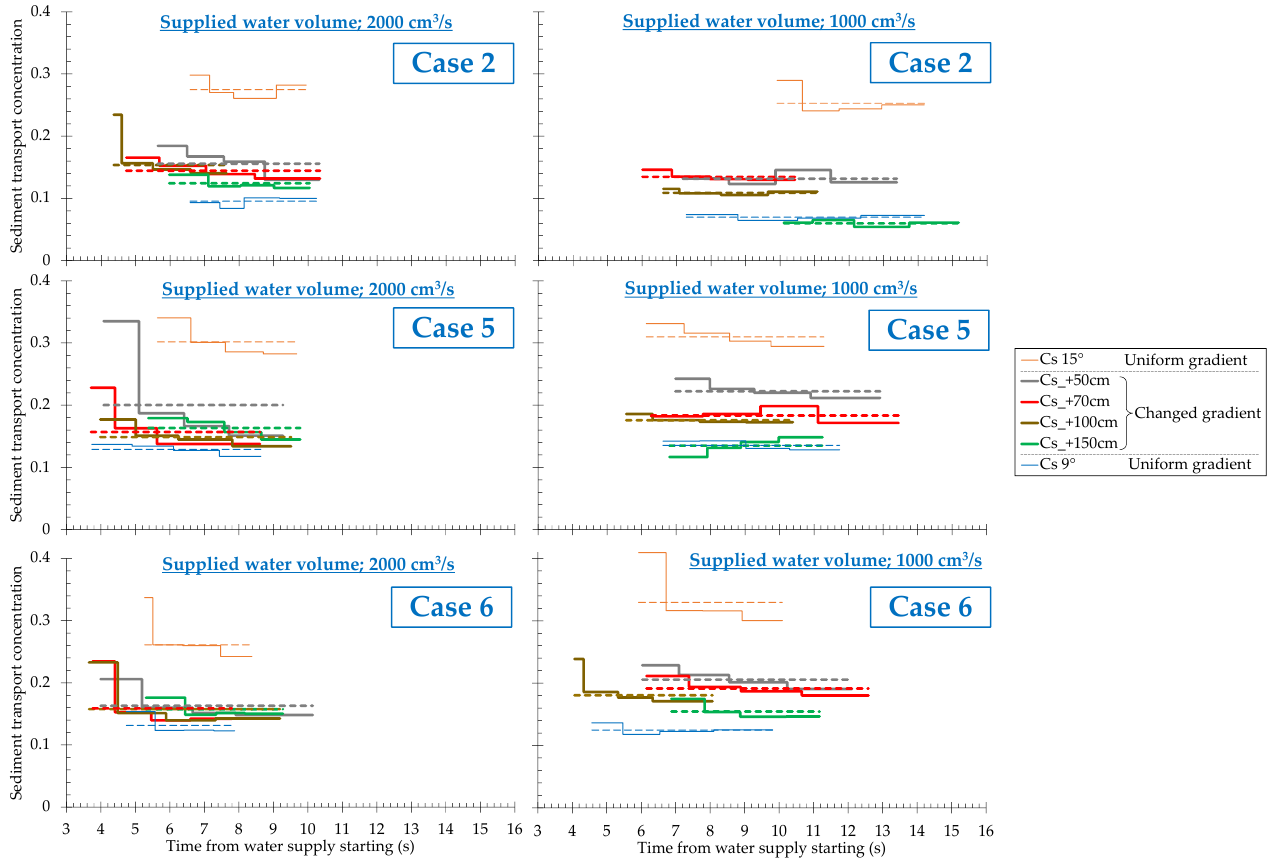
Figure 2. Time variations in sediment transport concentrations of the “frontal part” of the debris flow, 𝐶 𝑠 , for all gradient conditions in Cases 2, 5, and 6. Table 2. Averaged sediment transport concentrations of the “frontal part” of the debris flow, C s , for all cases with two inflow